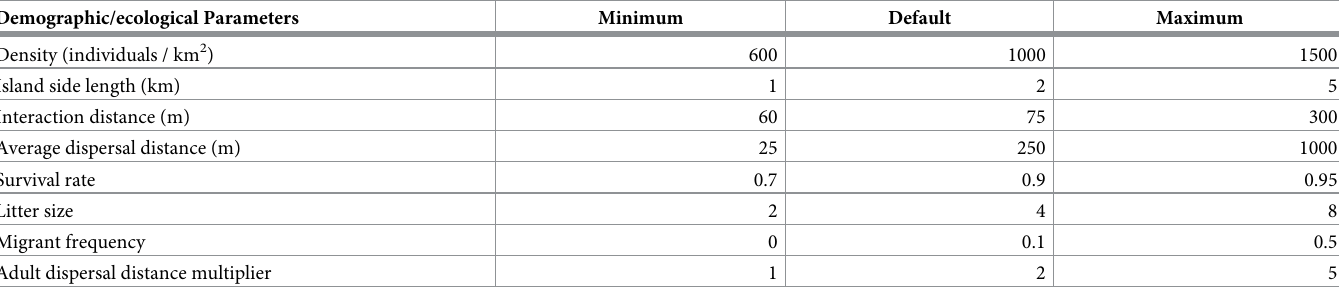
Table 1. Demographic/Ecological